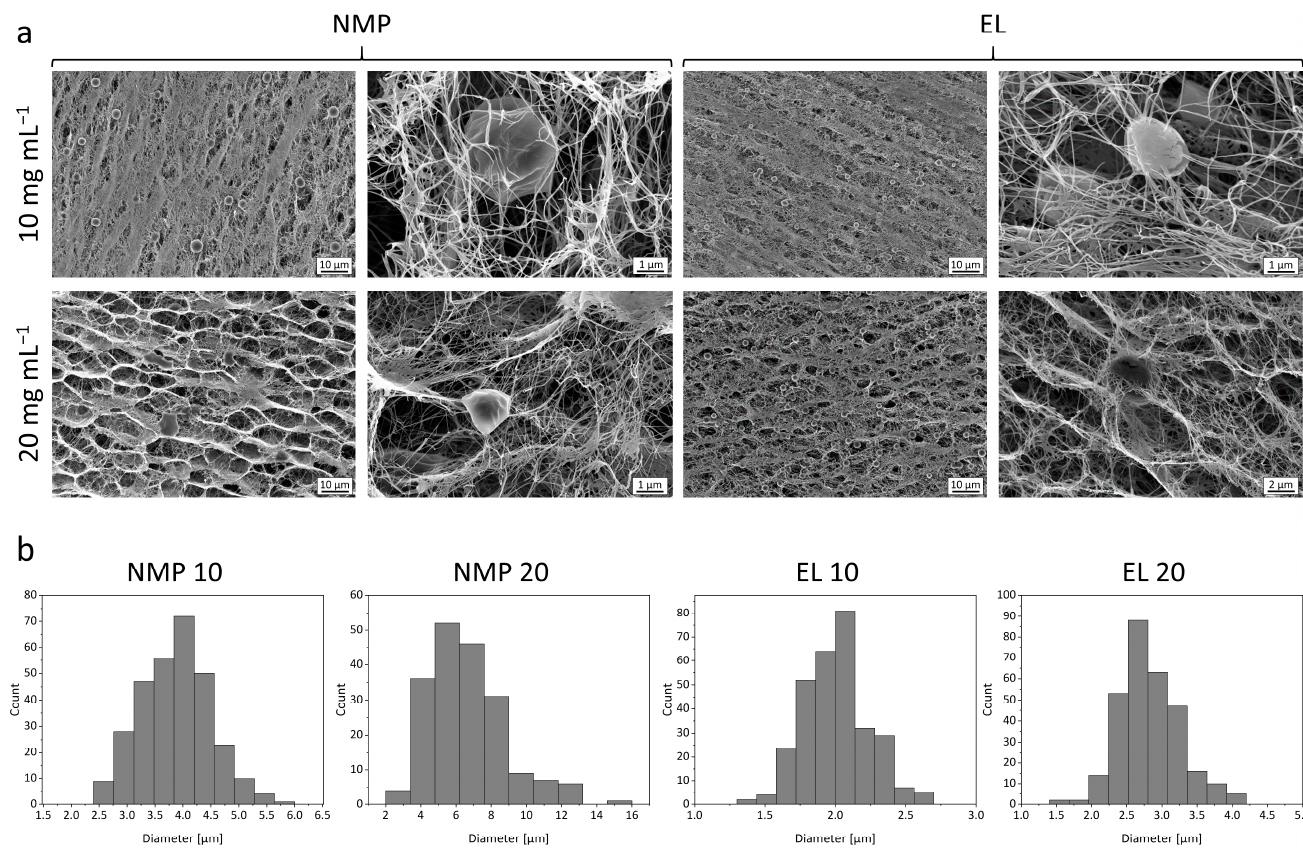
Figure 3. ( a ) Morphology of the PLGA phase within BNC depicted by scanning electron microscopy (1000 to 10,000 × magnification) of the cross-section of the fleeces after precipitation of 10 and 20 mg mL − 1 PLGA from the solvents NMP and EL and subsequent freeze-drying. ( b ) Distribution of the spherical equivalent diameter of PLGA particles incorporated into BNC determined by ImageJ ( n = 300 for NMP 10, EL 10, and EL 20, n = 192 for NMP 20).